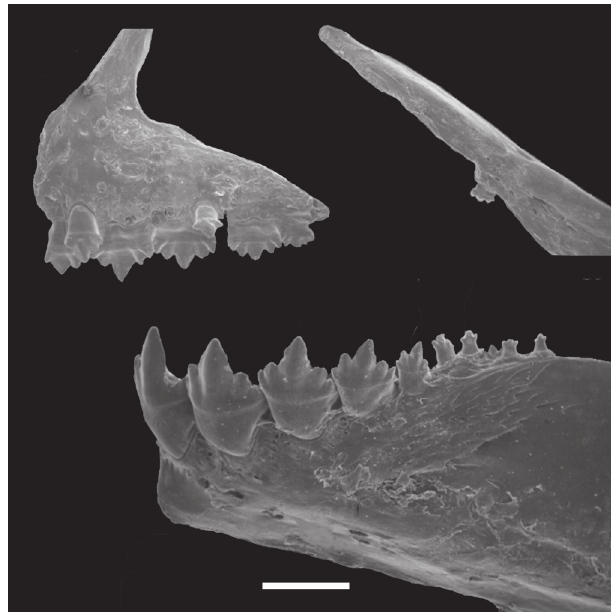
Fig. 5. Astyanax procerus , new species, MCP 25513, 78.0 mm SL, paratype, upper and lower jaws teeth, left side, lateral view. Scale bar = 1